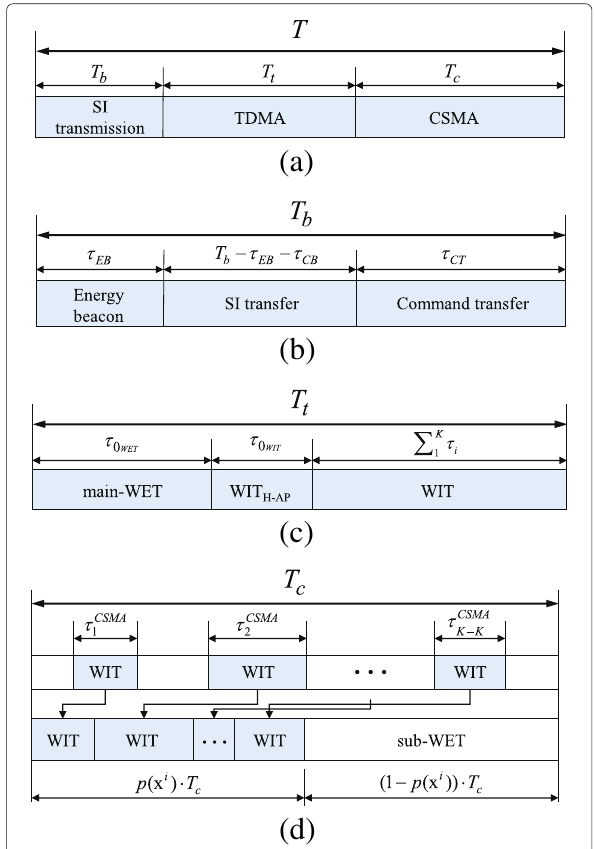
Fig. 2 The hybrid multiple access-based dual harvest-then-transmit protocol. a The proposed protocol, named H-DHT, which consists of SI transmission, TDMA, and CSMA period in a block time, denoted by T . For details, b describes the SI transmission period, denoted by T b , which consists of the energy beacon, SI transfer, and command transfer period. Futhermore, c shows the TDMA period, where main -WET is performed by the H-AT and nodes harvest energy during τ 0 WET . Then, the H-AP transmit information to nodes during any, and nodes transmit information to the H-AP during τ i . d shows the CSMA period, where sub -WET is performed and nodes transmit information during the rest of time